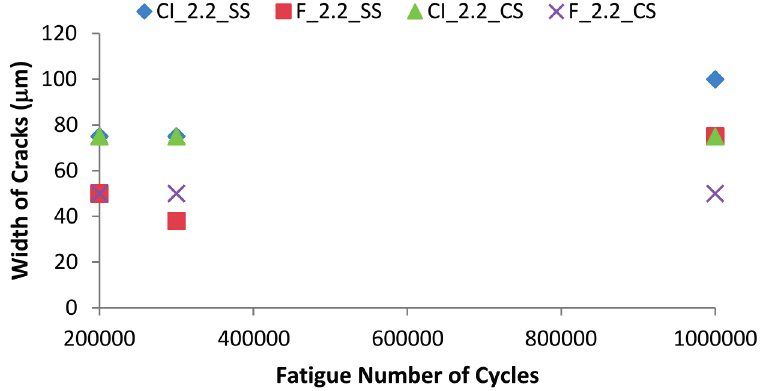
Figure 12. Crack widths at each fatigue number of